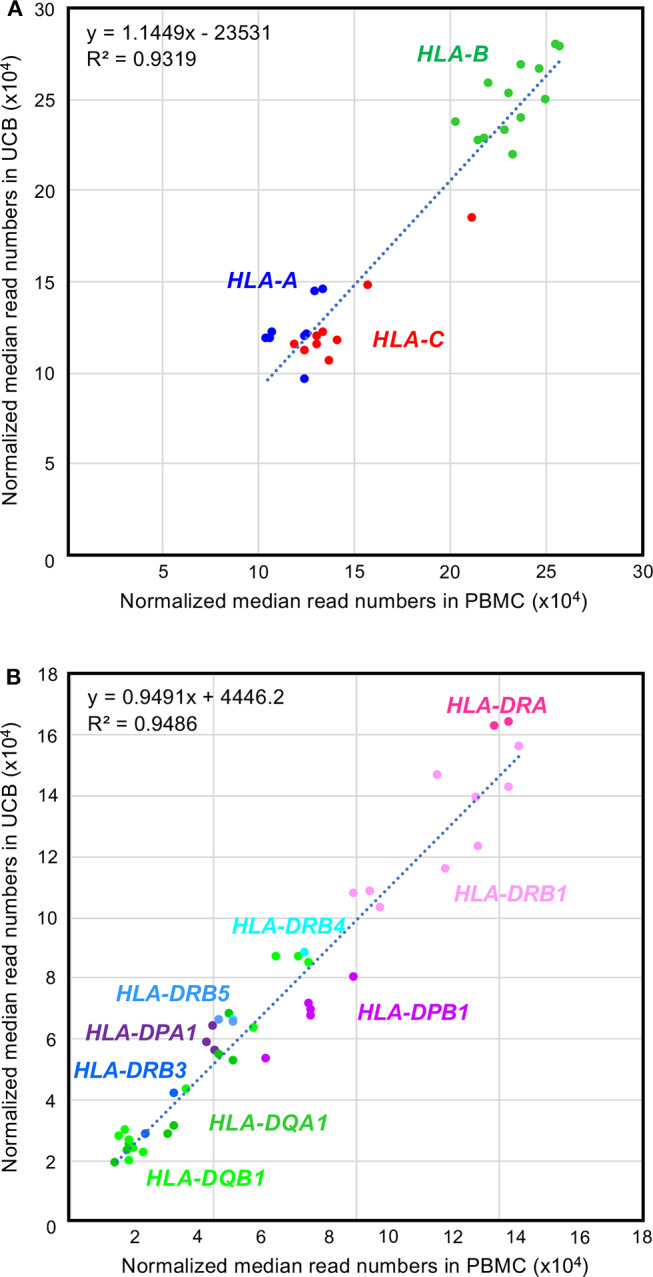
Comparison between the RNA expression levels for peripheral blood mononuclear cell (PBMC) and umbilical cord blood (UCB) samples. (A,B) Correlations of the RNA expression levels in the class I and class II loci, respectively. Normalized median reads (× 104) in PBMC and UCB (Table S7) were plotted in the horizontal and vertical axis, respectively.